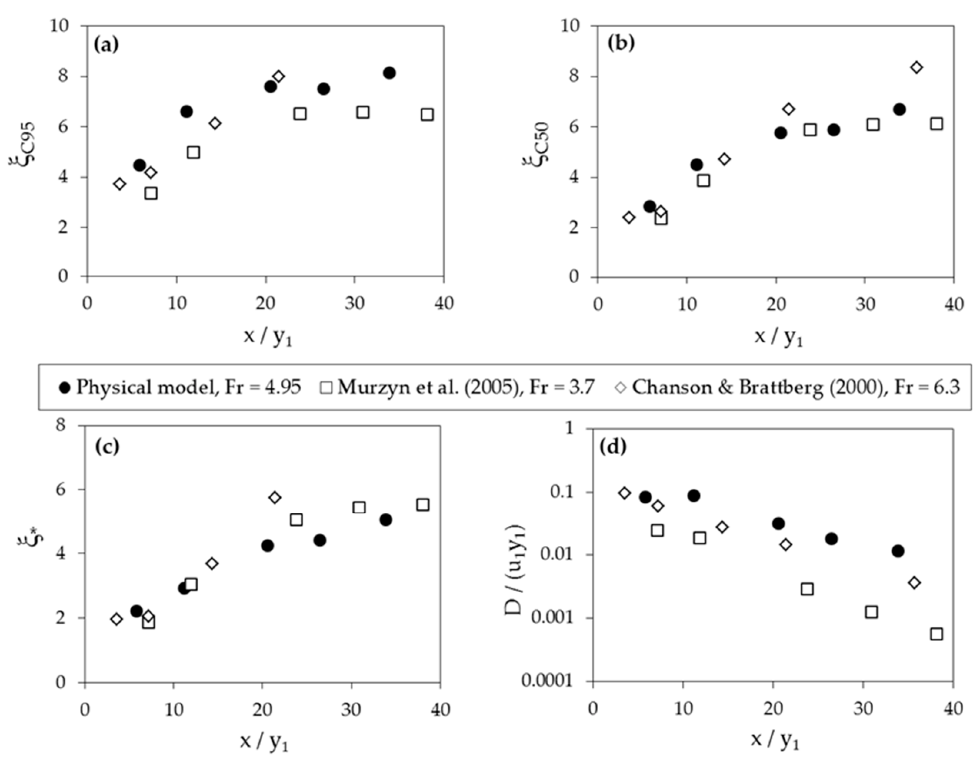
Figure 8. Parameters of the void fraction distribution in the hydraulic jump (upper region): ( a ) ( a ) Normalized height at which the void fraction is 0.95 ( ξ C95 ), ( b ) normalized height at which Normalized height at which the void fraction is 0.95 ( 𝜉 (cid:2887)(cid:2877)(cid:2873) ), ( b ) normalized height at which the void the void fraction is 0.5 ( ξ C 0.5 ), ( c ) normalized height of the boundary between regions ( ξ ∗ ), ( d ) di ff usion fraction is 0.5 ( 𝜉 (cid:3004)(cid:2868).(cid:2873) ), ( c ) normalized height of the boundary between regions ( 𝜉 ∗ ), ( d ) diffusion coe ffi cient ( D coefficient ( 𝐷 ).